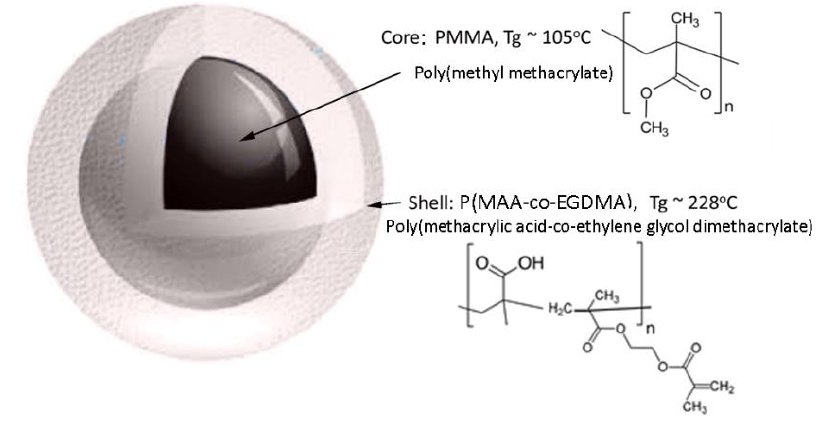
Figure 1. Schematic representation of the produced core-shell copolymer PMMA@P(MAA-co- EGDMA)